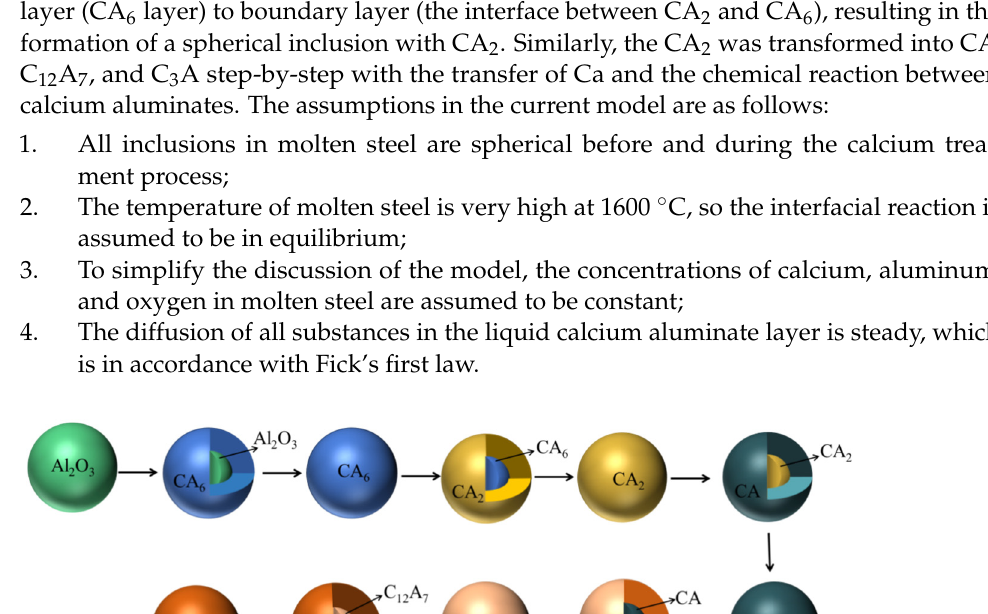
layer (CA 6 layer) to boundary layer (the interface between CA 2 and CA 6 ), resulting in the formation of a spherical inclusion with CA 2 . Similarly, the CA 2 was transformed into CA, C 12 A 7 , and C 3 A step-by-step with the transfer of Ca and the chemical reaction between calcium aluminates. The assumptions in the current model are as follows: